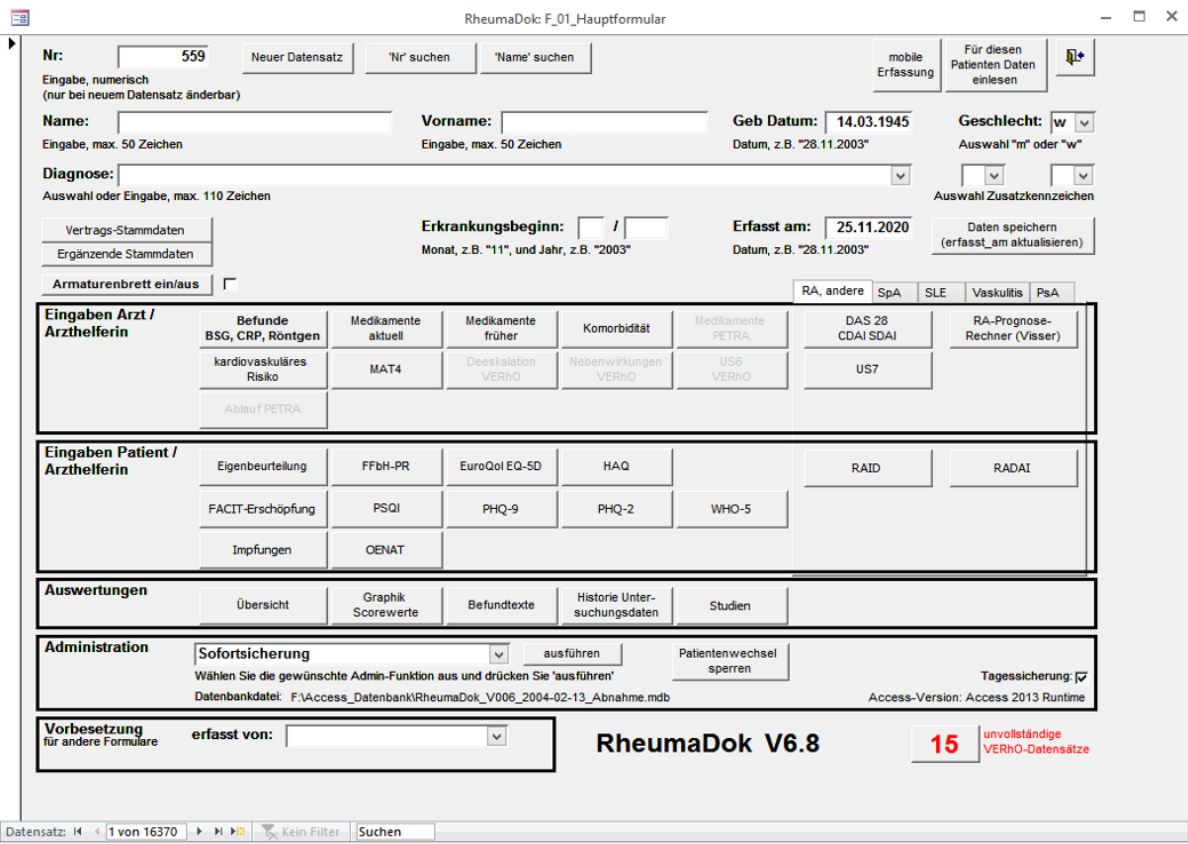
Figure 4. Screenshot of